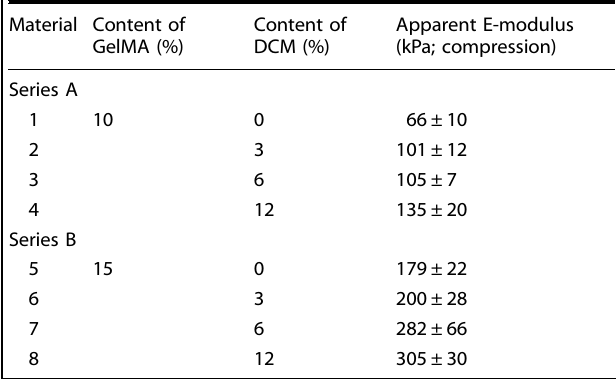
Table 1. Experimental data from compression tests of the fully hydrated specimens of materials 1 –